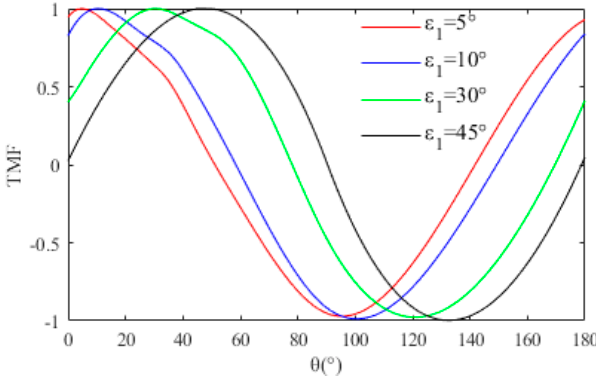
Figure 5. Photograph of the experimental configuration.